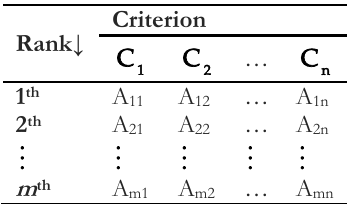
Table 5. Ranking matrix of each alternative in each